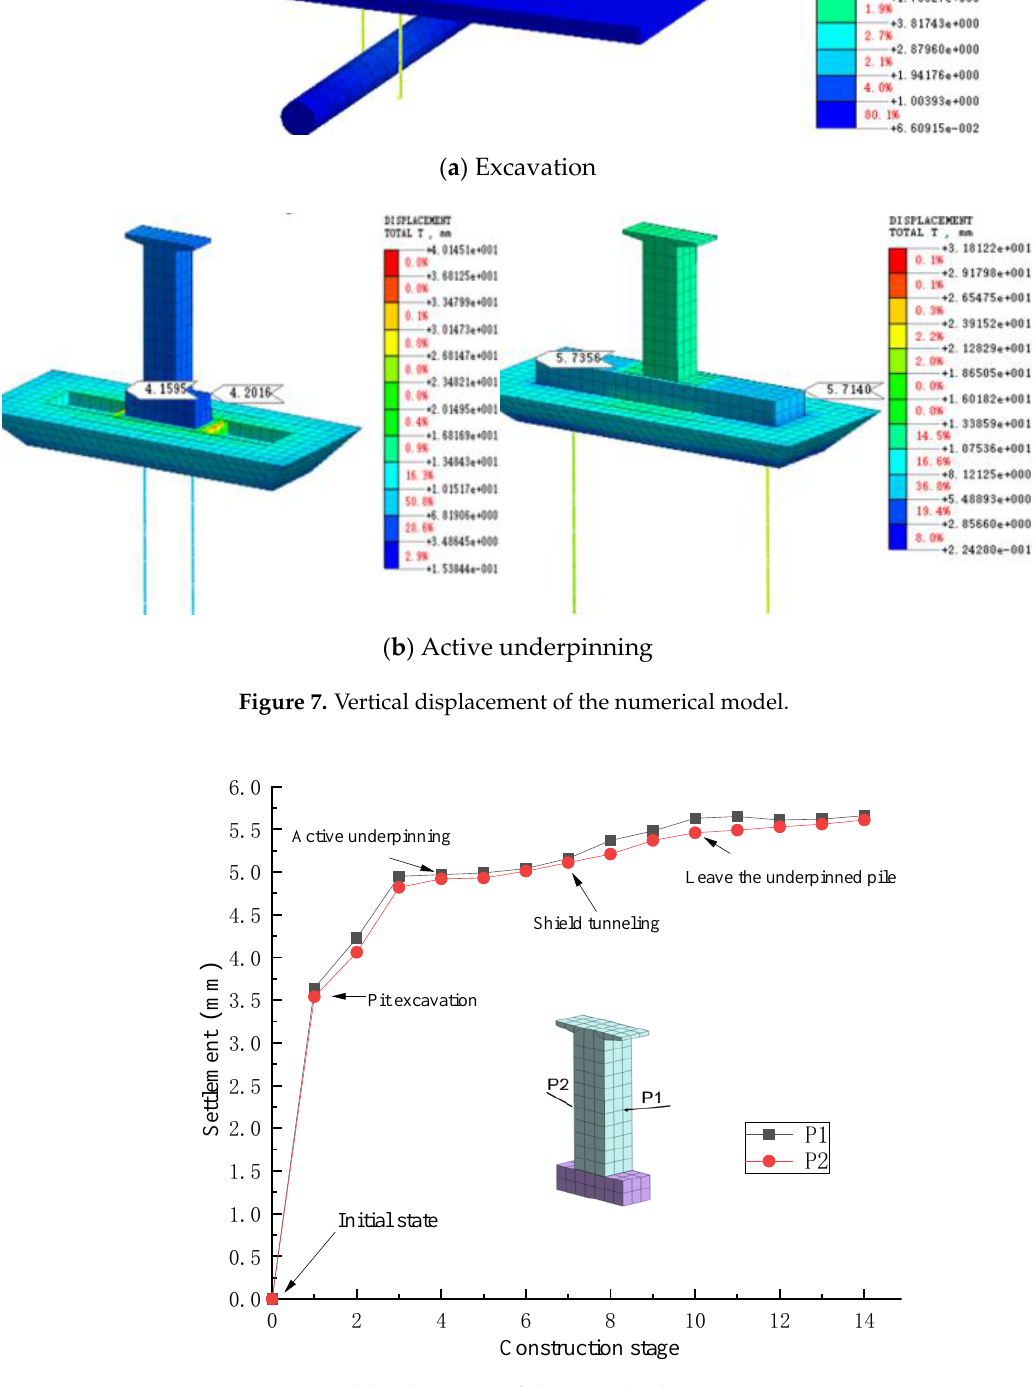
Figure 8. Vertical displacement of the existed pile cap.